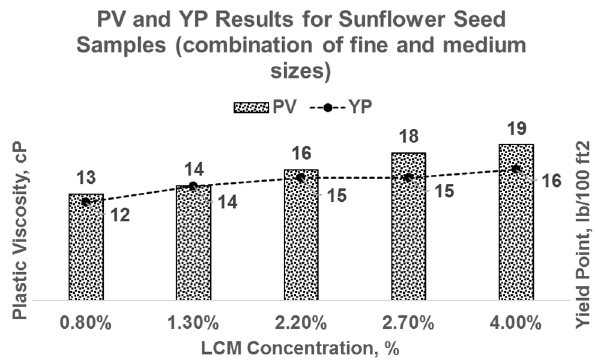
Fig. 6 PV and YP results for combination of fine and medium sizes sunflower seed